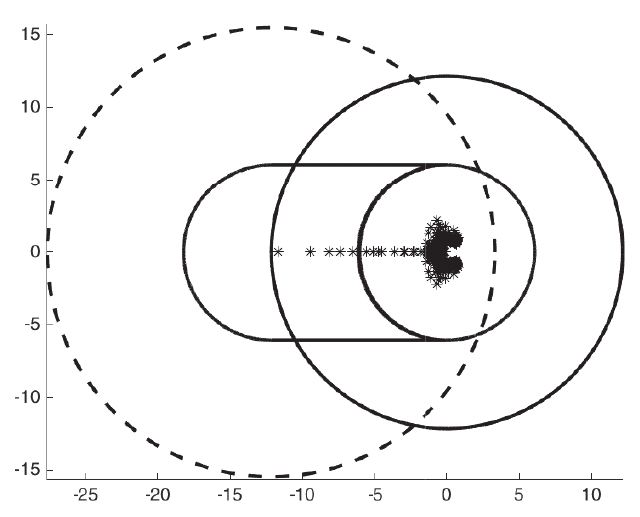
Figure 1: Eigenvalue inclusion regions from Theorems 2.4, 3.3, and 4.3.